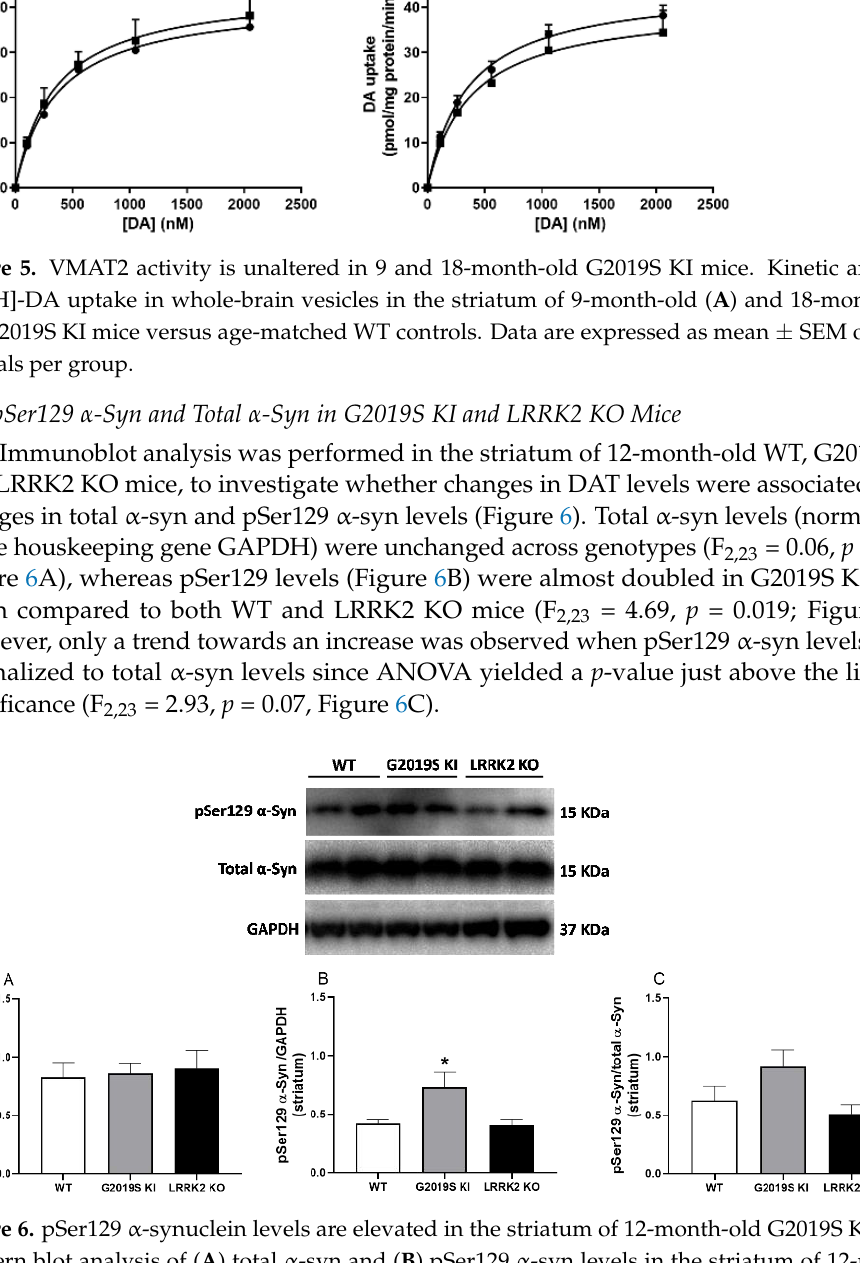
Figure 7. pSer129 α -synuclein levels are elevated in the striatum of 12-month-old LRRK2 KO mice. Immunohistochemistry was performed in striatal slices of 12-month-old G2019S KI and LRRK2 KO mice in comparison with age-matched WT mice. Optical density (O.D.) of pSer129 α -syn ( A ) and total α -syn ( B ) immunostaining was calculated. Data are expressed as mean ± SEM of n = 6 mice per group. Representative images were provided in the upper panels (scale bar = 100 µm). Statistical analysis was performed by ANOVA followed by the Tukey test for multiple comparisons. * p < 0.05 different from WT mice.